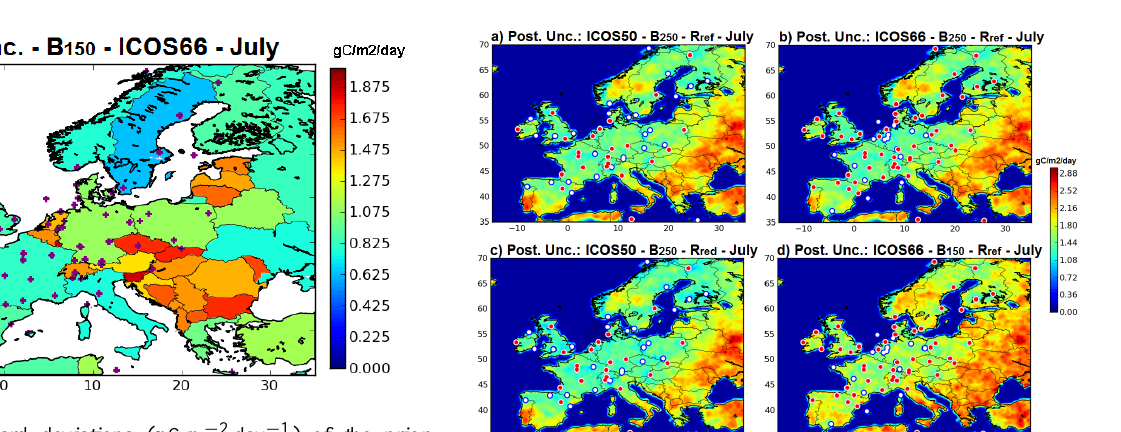
Figure A1. Standard deviations (gCm − 2 day − 1 ) of the prior flux uncertainties at country scale for July when consider- ing B 150 . Red dots: ICOS66. Red/blue colors indicate rela- tively high/low uncertainties (with min = 0gCm − 2 day − 1 and max = 1.975gCm − 2 day − 1 in the color scale).